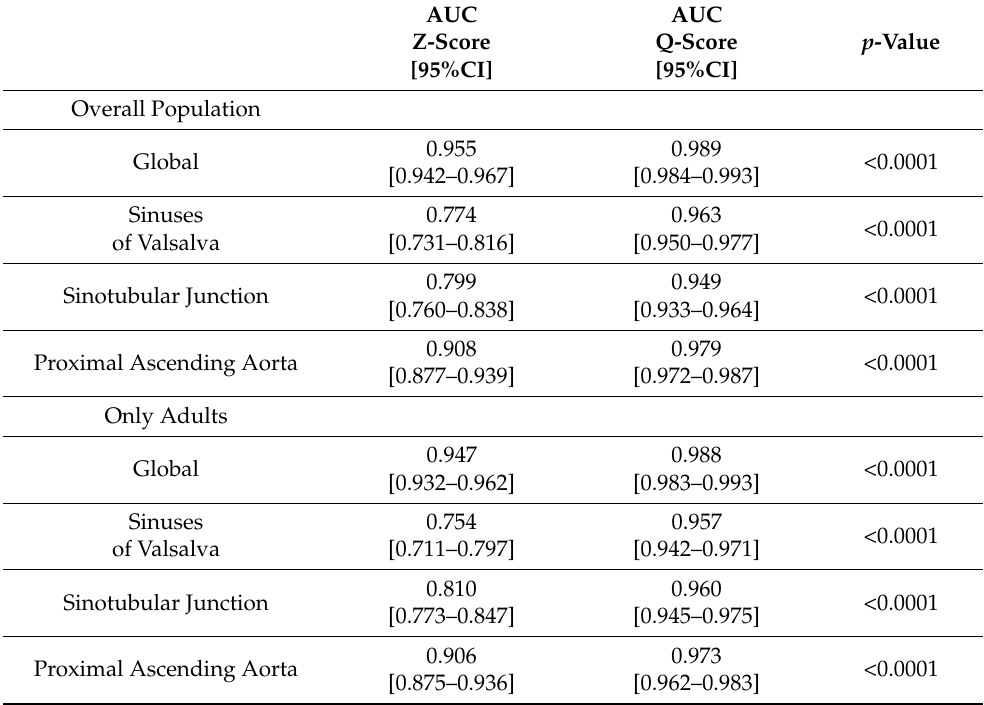
Table 4. AUC for models trained on the overall population, and only on subjects aged >15 years.